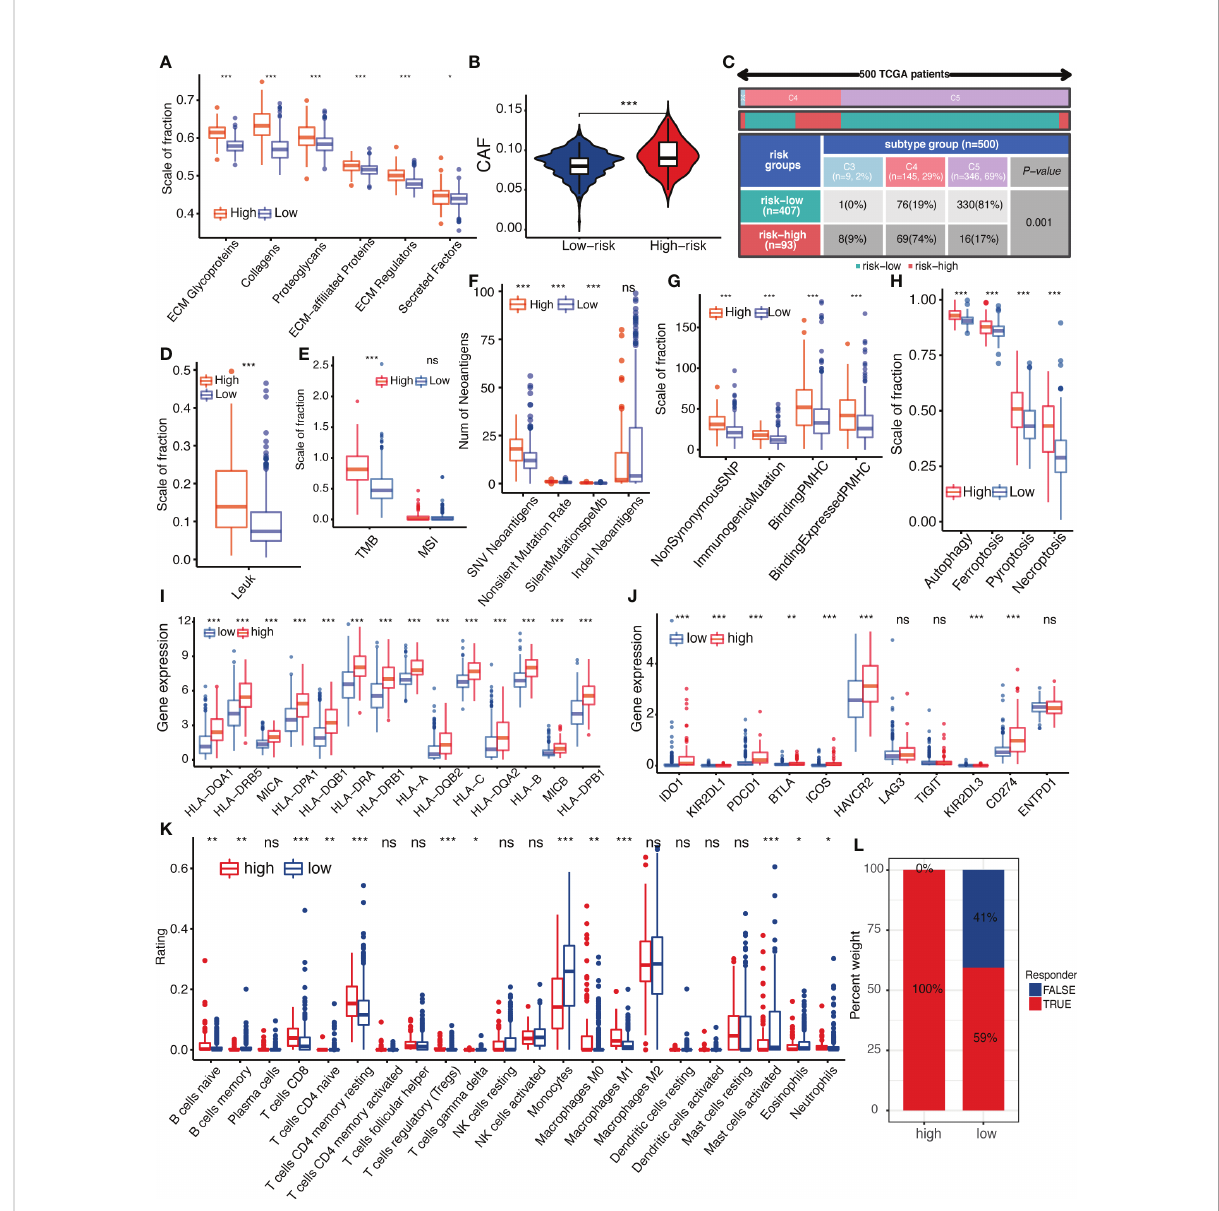
FIGURE 7 Relationship between IGFBPScore and the tumor microenviroment. (A) Differences in extracellular matrix components and (B) cancer-associated fi broblasts in High-risk and Low-risk groups. (C) Proportion of pan-cancer immune subtypes and (D) leukocyte fraction in High-risk and Low-risk groups. ( E – H ) Differences in (E) TMB, MSI, (F) SNV neoantigen count, (G) antigenic peptide-major histocompatibility complex, and (H) immunogenic death of High-risk and Low-risk groups. (I) Differences in the expression of major histocompatibility complexes and (J) immune checkpoints between Low-risk and High-risk groups. (K) Differences in tumor-in fi ltrated immune cells between High-risk and Low-risk groups. ( L ) Differences in response to immunotherapy between High-risk and Low-risk groups. TMB, tumor mutational burden; MSI, microsatellite instability; CAFs, cancer-associated stromal cells; LF, leukocyte fraction; SNV, single nucleotide variants; indel, insertional deletion mutations; MHV, major histocompatibility complex-related genes; pMHC, MHC-binding SNV-derived peptides. For all experiments, mean rank, *p<0.05, **p<0.01, ***p<0.001. ns, no signi fi